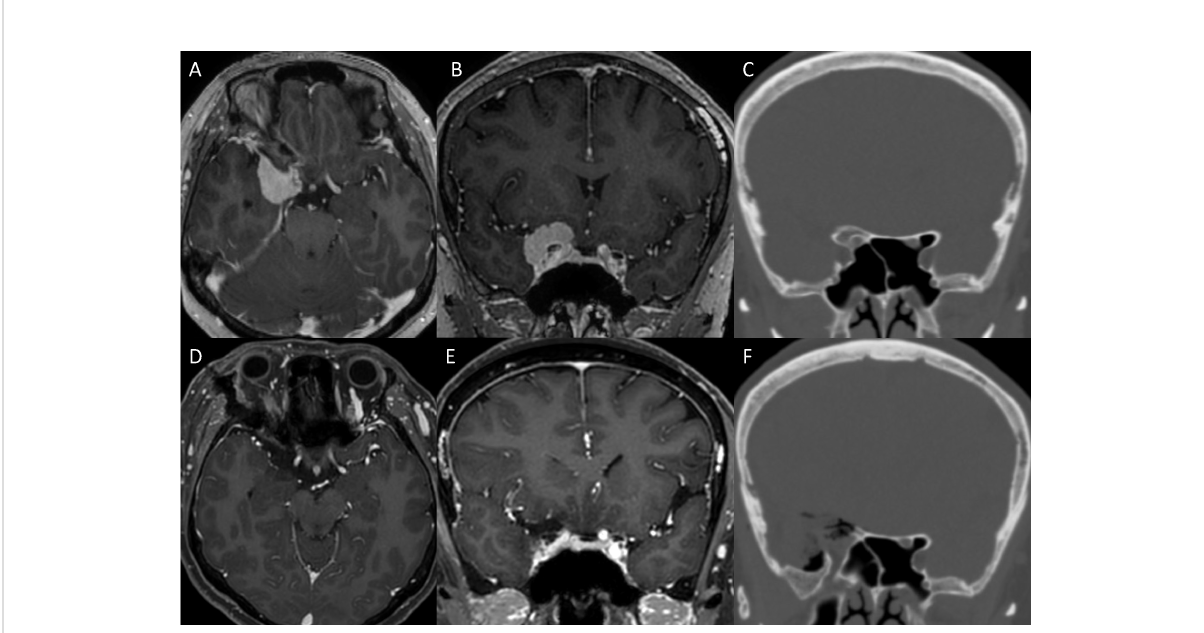
FIGURE 8 Illustrative case. (A, B) Preoperative MRI showing a mass in the central skull base, diagnosed as anterior clinoidal meningioma. (C) Preoperative CT showing the hyperostotic ACP. (D – F) Complete removal of the ACP and the tumor was con fi rmed with postoperative CT and MRI. ACP, anterior clinoidal process; CT, computed tomography; MRI, Magnetic resonance